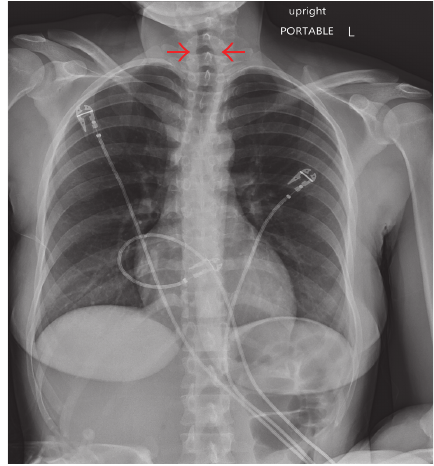
Figure 2: Hospital day 1 anterior-posterior (portable) chest radio- graph demonstrating resolution of subglottic stenosis (between red arrows).